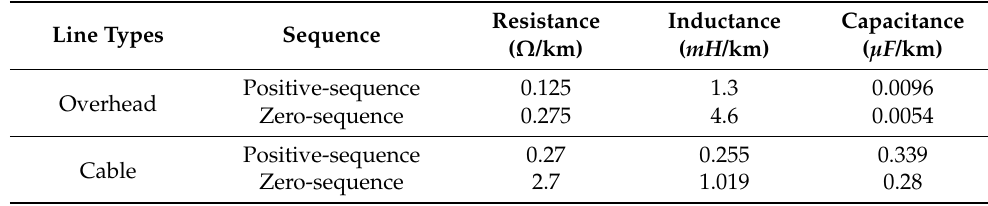
Figure 11. Resonant grounding distribution system model. Table 2. Line impedance parameters.